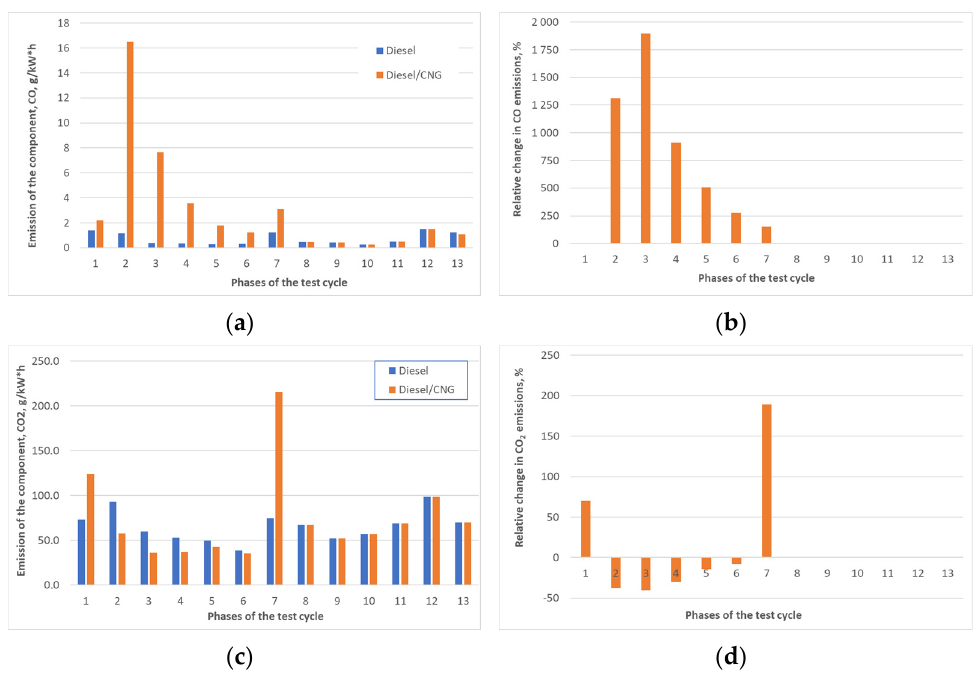
Figure 16. Emission of gaseous exhaust components during the R49 test on diesel fuel and diesel/CNG supply for individual phases of the test: ( a ) emission of CO, ( b ) relative change in emission of CO, ( c ) concentration of CO 2 and ( d ) relative change in emission of CO 2 .